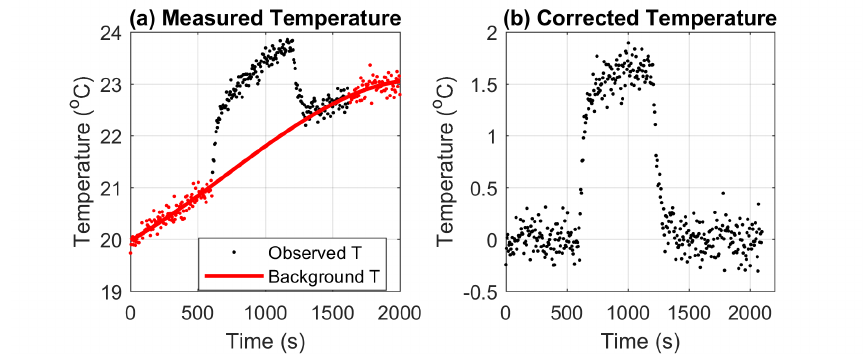
Figure 3. Soil temperature measurement during a heat pulse before ( a ) and after ( b ) background temperature correction. Red dots in ( a ) are the temperature measurements used for estimating the background temperature (red solid line) during the heat